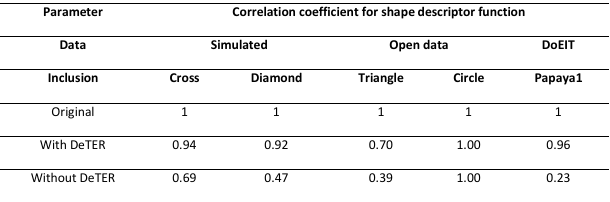
Table 1: Improvements in correlation coefficient for shape descriptor function